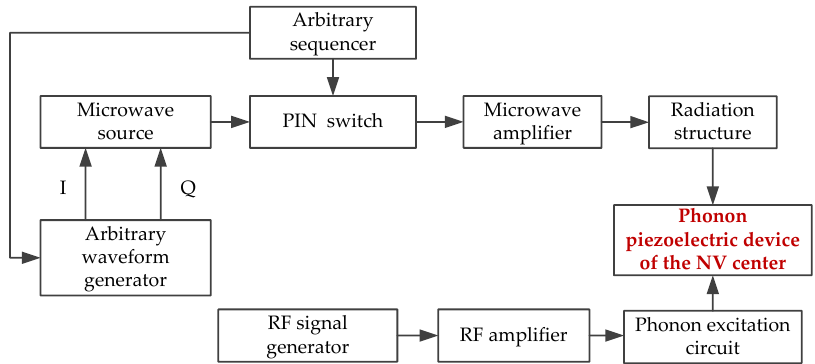
Figure 20. The architecture of the phonon-coupled manipulation module.